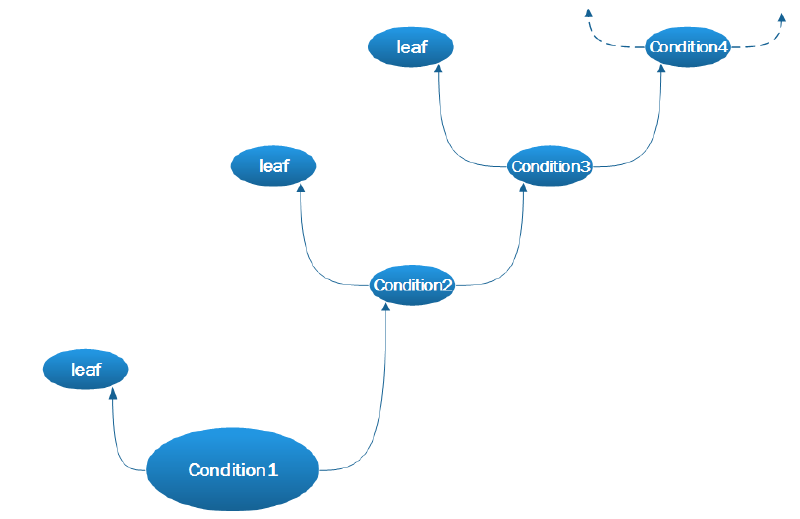
Figure 2. Decision tree for the fine tree algorithm.